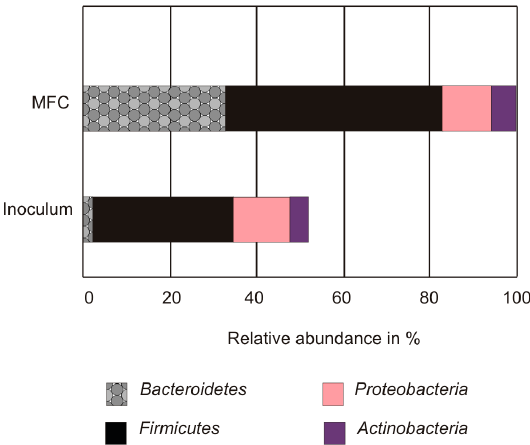
Figure 3. The relative abundance of different bacteria (at the phyla level) present in the inoculum before and after operation of the MFC.